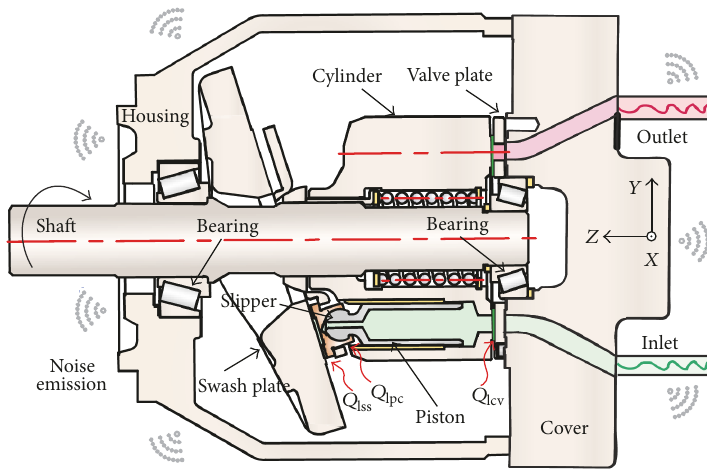
Figure 1: Diagram of the axial piston